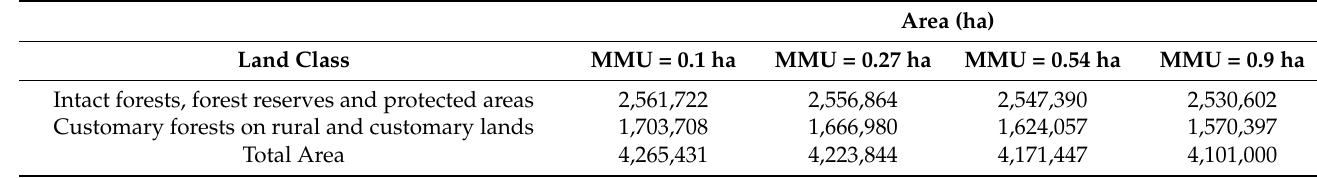
Table 2. Baseline Area of Forest Cover. The baseline forest cover is presented with our minimum mapping unity (MMU) of 0.1 ha, broken down by (a) intact major forest areas outside of reserves and not on agricultural land, forest reserves, and other protected forests, and (b) tree complexes, woodlots, agroforestry and other forest areas in agricultural land with MMU greater than 0.1 ha. Also presented are forest area estimates using larger MMUs from 0.27 ha, 0.54 ha (which closely aligns with the Government of Malawi’s definition), and 0.9 ha. Forest area estimates do not vary significantly with changes in the MMU but larger MMUs produce lower